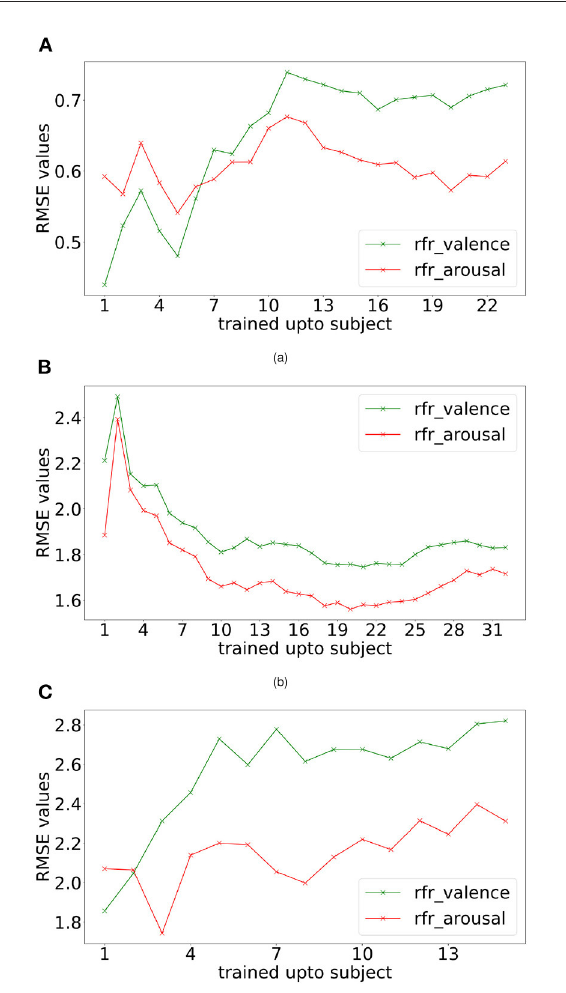
FIGURE4 Incremental learning performance. Valence and arousal RMSE readings were obtained with incremental learning for DREAMER (A) , DEAP (B) , and OASIS EEG (C) datasets using random forest regressor (rfr).